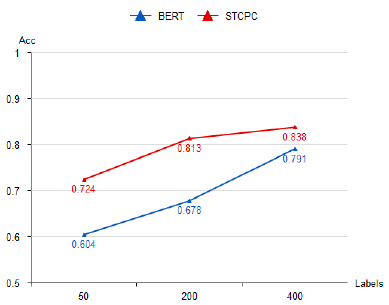
Figure 8. Amazon Reviews dataset training results.